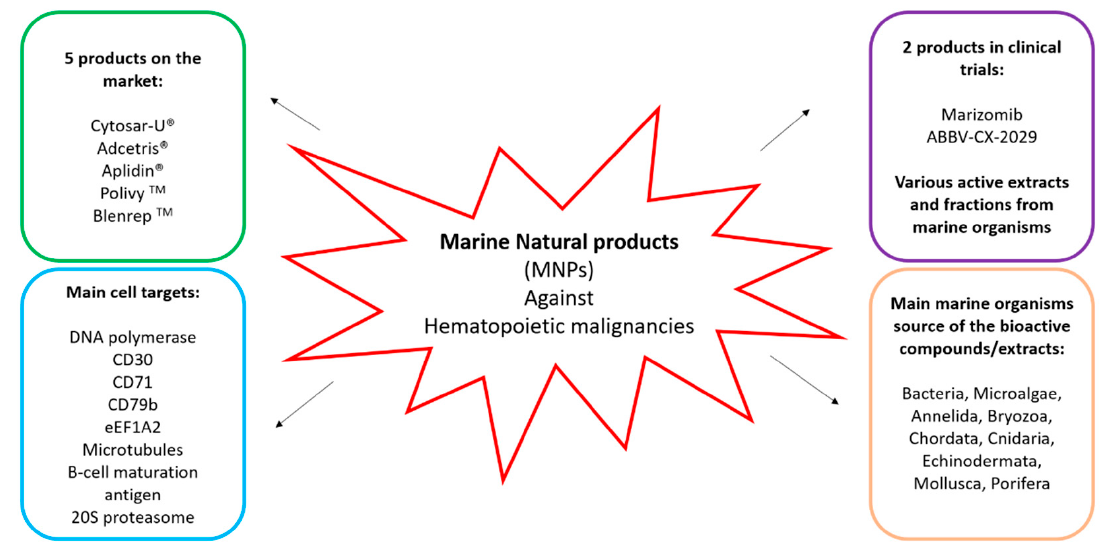
Figure 1. Summary of compounds derived from marine organisms currently on the market or in clinical trials and the known molecular targets.